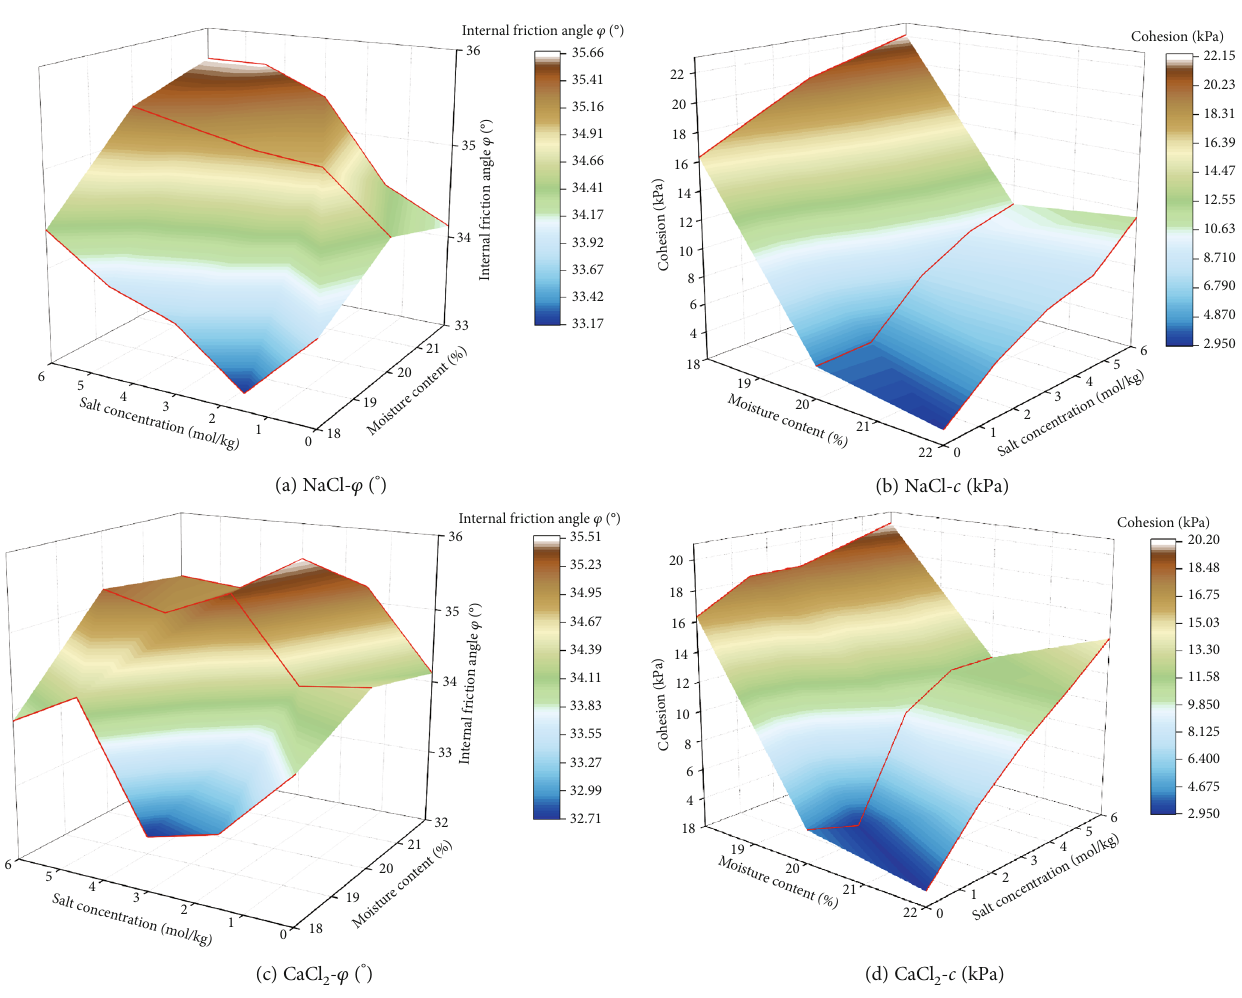
Figure 5: E ff ect of salt concentrations of bulk solution on shear strength